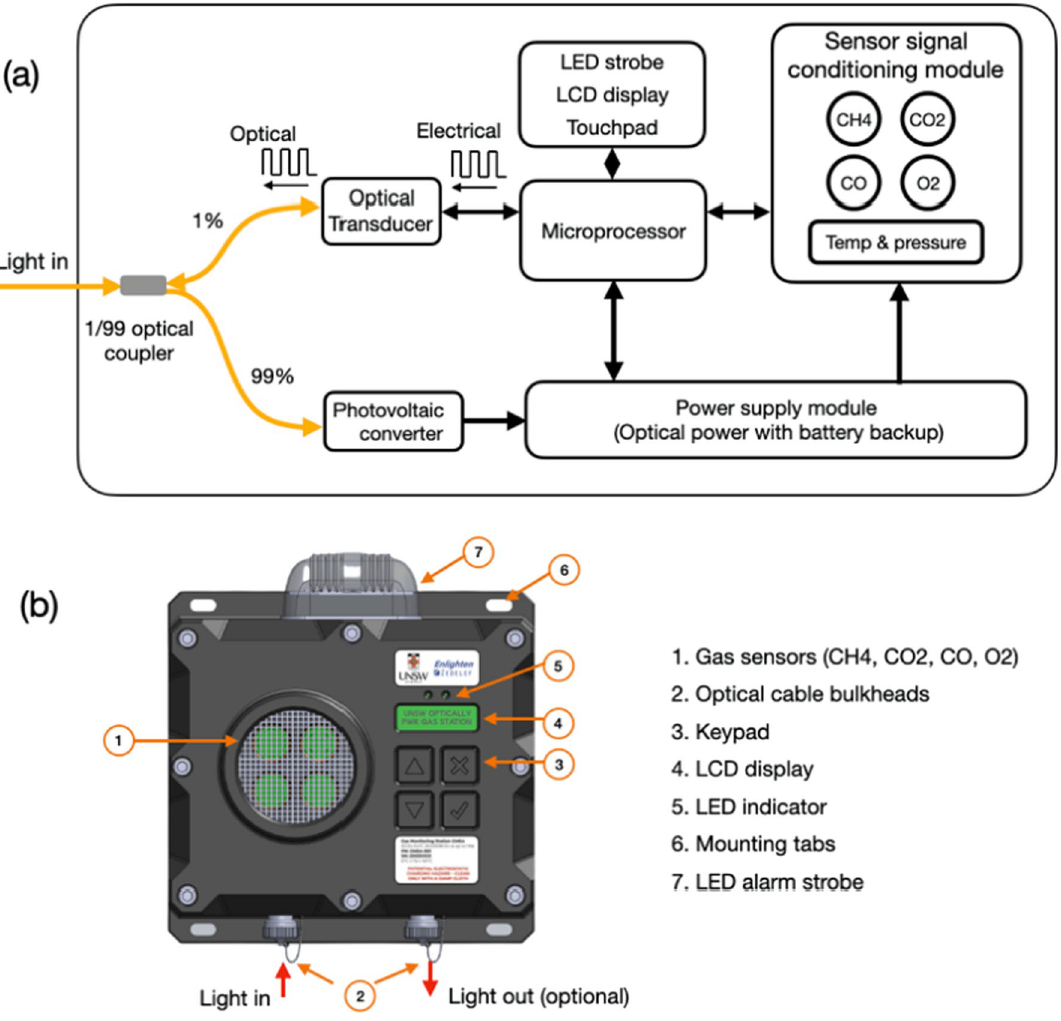
Fig. 3 Optically powered gas monitoring station. a Block diagram, and b Assembly and part names. Note how having both optical in- and out- ports allows to daisy chain a number of